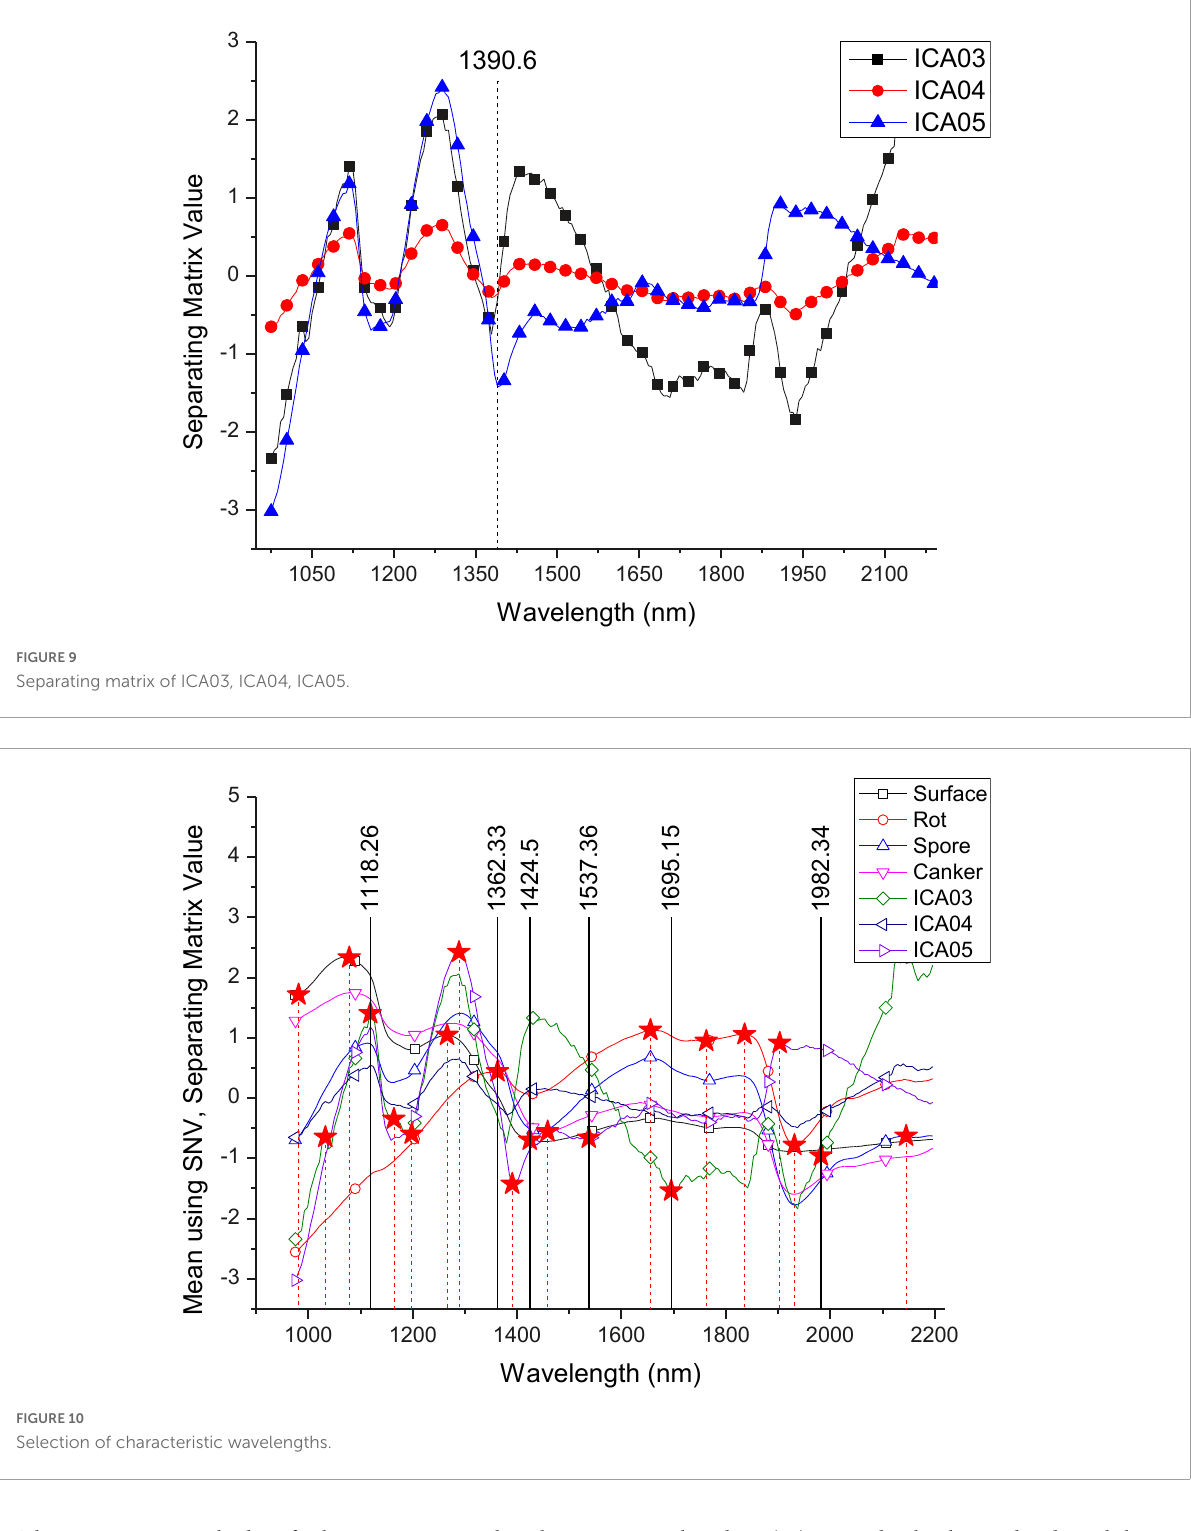
The extraction methods of characteristic wavelengths include principal component analysis (PCA) and independent principal component analysis (ICA). ICA has a superior applicability to solve the problem of blind source separation in